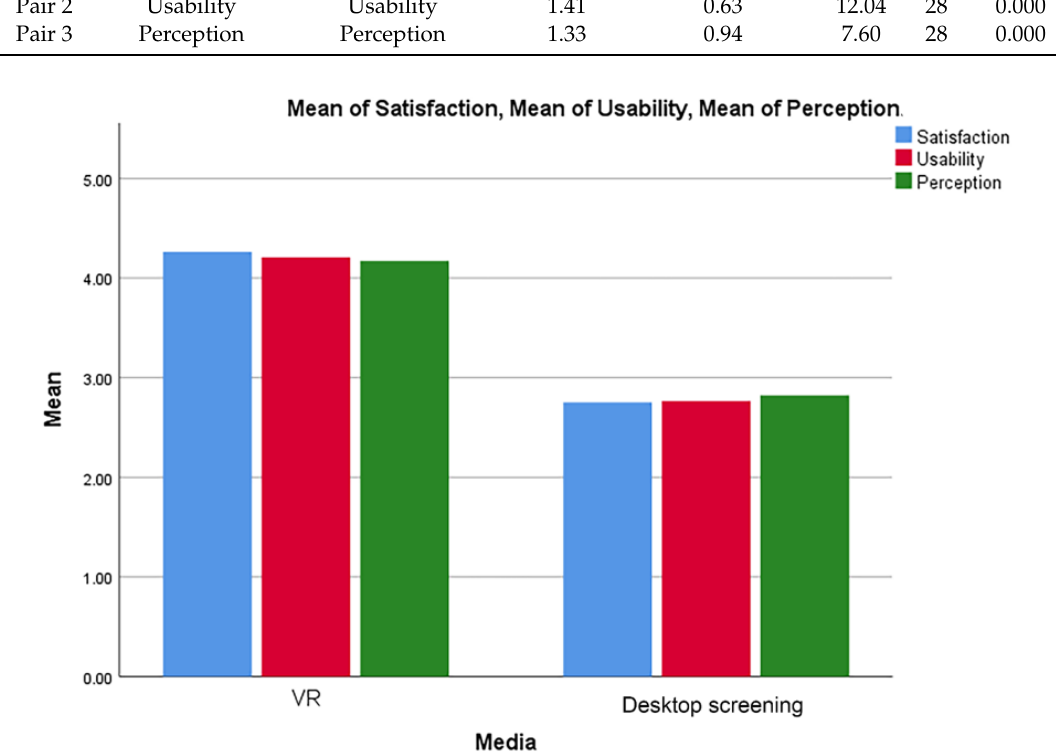
Figure 10. Effect of media use (VR and desktop screening) on student satisfaction, usability, and perception.